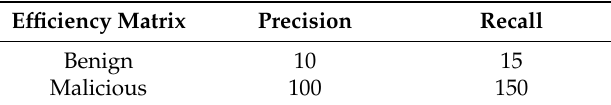
Table 9. Efficiency Matrix.